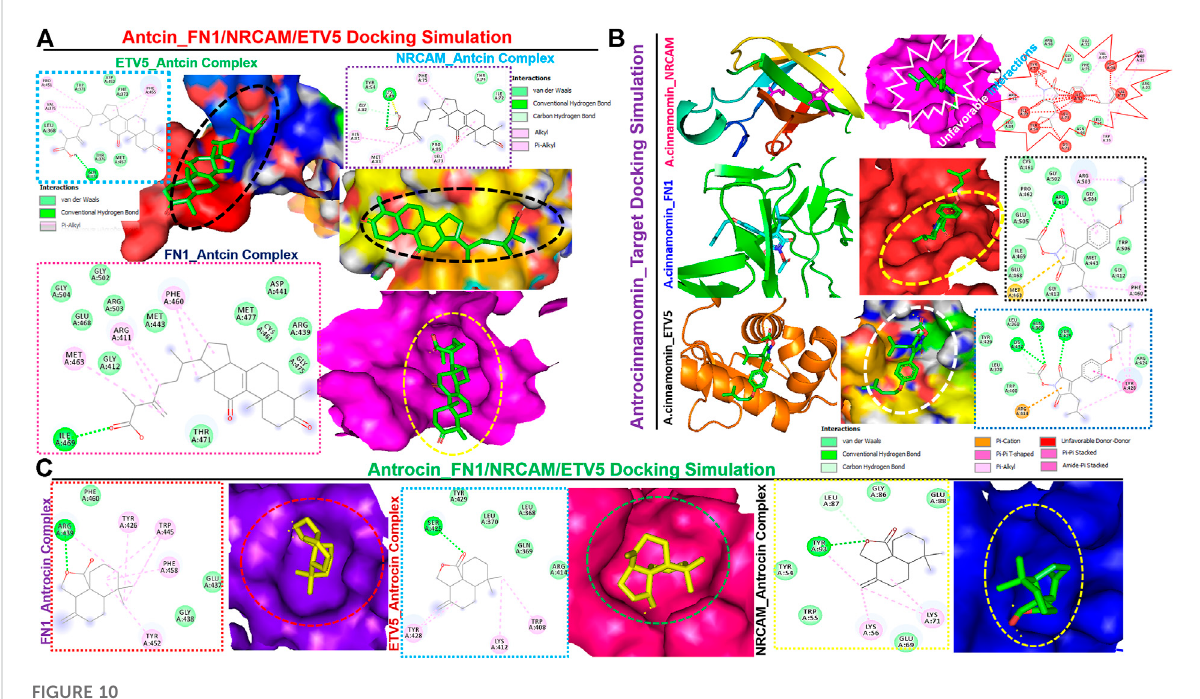
FIGURE 10 Molecular docking pro fi le of FN1/ETV5/NRCAM with the phytocompound isolated from Taiwan Antrodia camphorata. Docking pro fi le of (A) antcin, (B) antrocinnamomin, and (C) antrocin with FN1/ETV5/NRCAM.